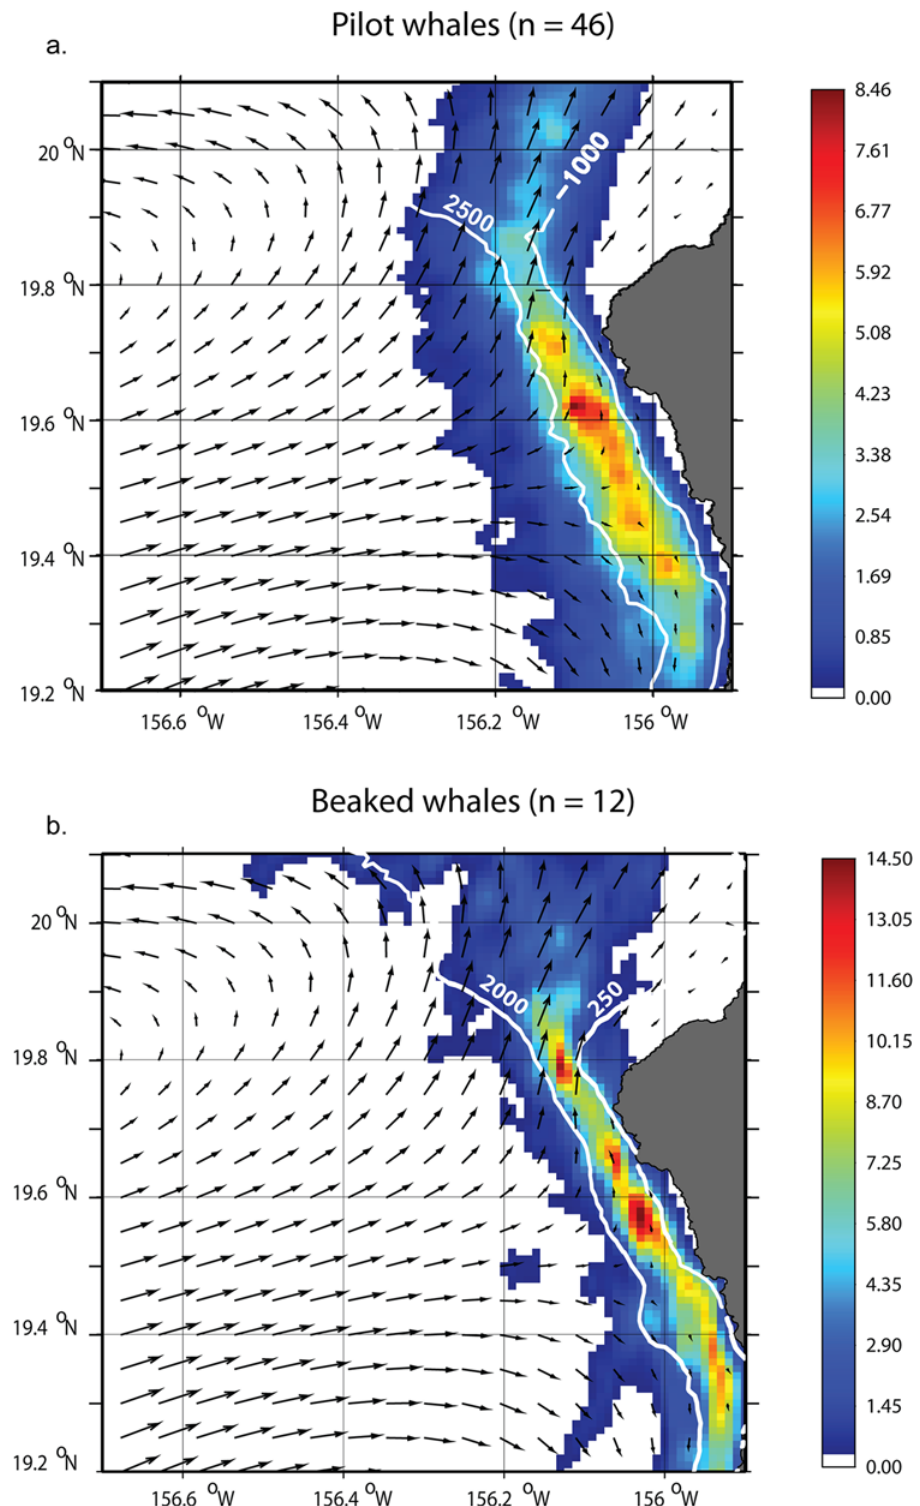
Fig 3. Kernel density estimates. Kernel density estimates of short-finned pilot whales (a) and Blainville ’ s beaked whales (b) from satellite tag data (color scale) overlaid with bathymetry contours (white lines) and